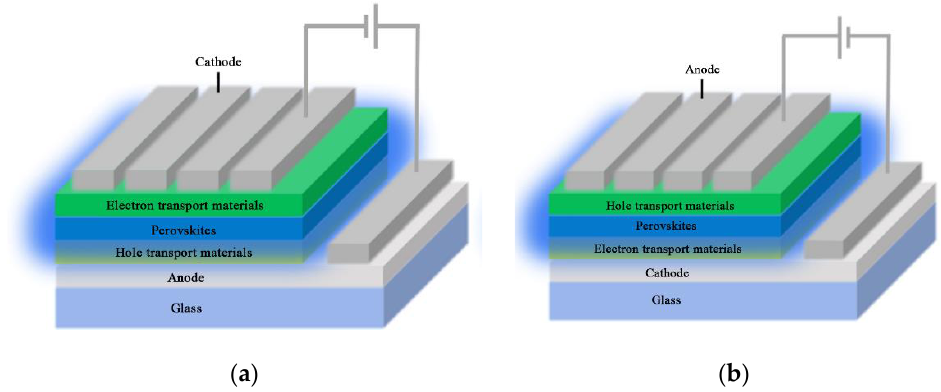
Figure 2. ( a ) Typical p - i - n architecture of PeLED; ( b ) Typical n - i - p architecture of PeLED. Reprinted with permission from Ref. [1]. 2020, China Association for Science and Technology.